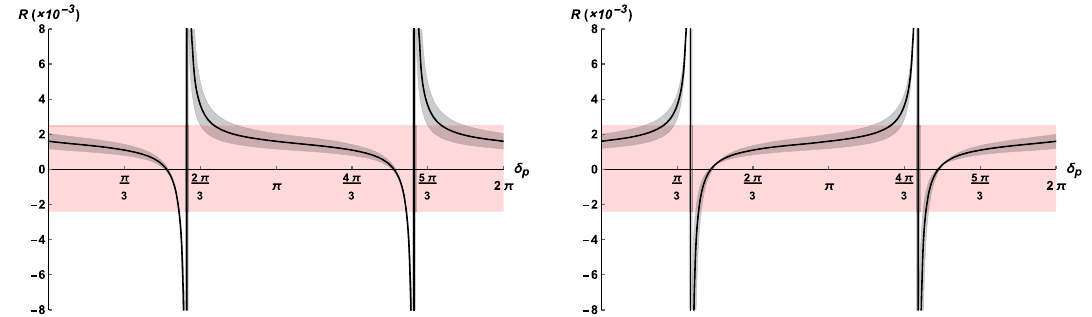
Fig. 3 Ratio R dependent on δ p in the cases of negative (left) and positive (right) δ I , in which the horizontal pink shadow is 1 σ experimental limitation to date taken from HFLAV [44]